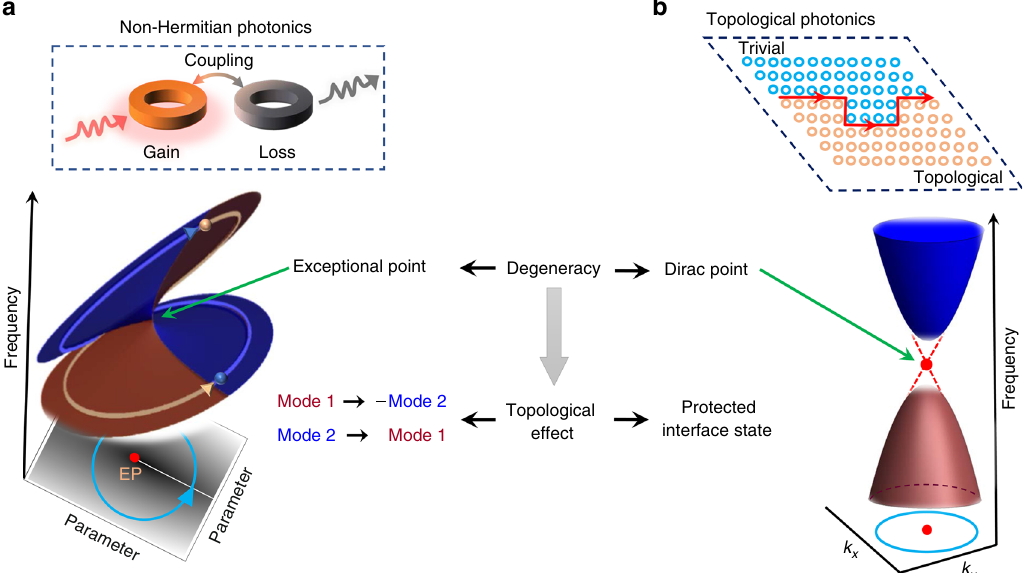
Fig. 1 The topology of exceptional point and Dirac point degeneracies. A generic photonic non-Hermitian system is composed of coupled gain and loss materials such as ring resonators (inset of a ). An exceptional point (EP) can appear in the frequency spectrum of such a system at some critical values of the coupling and the gain/loss coef fi cient. The topological properties of a second-order EP are best understood by two Riemann surfaces (shown in blue and brown colours) connected at the square root branch point. The two surfaces represent two eigenfrequencies with complex values. An encircling of the EP can be induced by suitable parameter changes. Starting on the upper surface, one ends up on the lower surface after one round and vice versa (the states move smoothly from one surface to the other). Encircling twice brings one back to the initial point, but the modes acquire a π -Berry phase; after 4 cycles, the modes return to their starting phases. For a non-adiabatic encircling, the states suddenly jump from one surface to the other, leading to different fi nal states depending on the direction of encircling (not shown). A schematic of a topological band structure near the Dirac point degeneracy is shown in ( b ). The Berry phase, calculated over a closed loop in the Brillion zone, is related to the topological invariant, known as the Chern number. The gapless edge mode (red dashed line) connects the conduction and valence band. Such an edge state propagates along the interfaces formed by topologically different materials (see red line in the inset). Between the panels, we schematically point out the fundamental degeneracies associated with non-Hermitian and topological